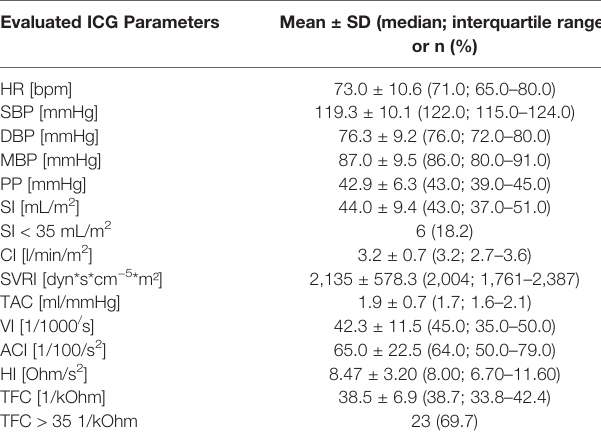
TABLE 2 | Hemodynamic parameters assessed via impedance cardiography (ICG) in patients with acromegaly (AC). Evaluated ICG Parameters Mean ± SD (median; interquartile range)